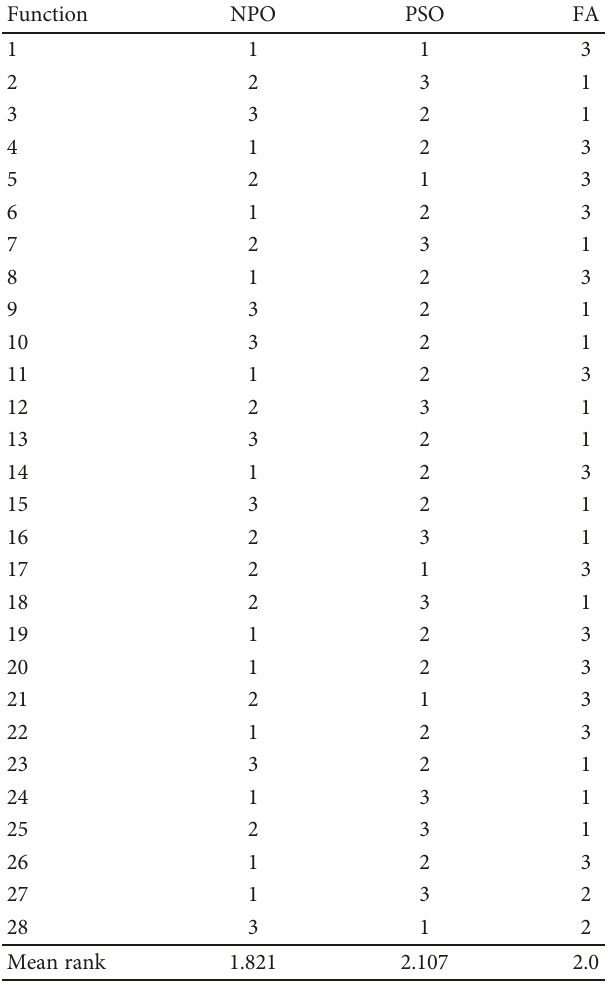
Table 2: Performance comparison of NPO, PSO, and FA in the mean ranking.